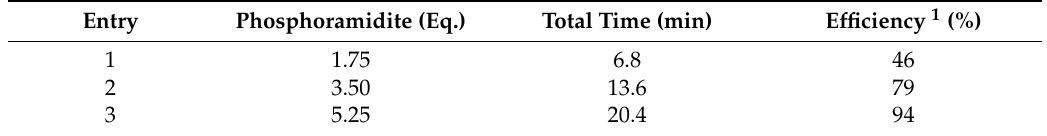
Table 1. Impact of phosphoramidite equivalents on coupling efficiency.